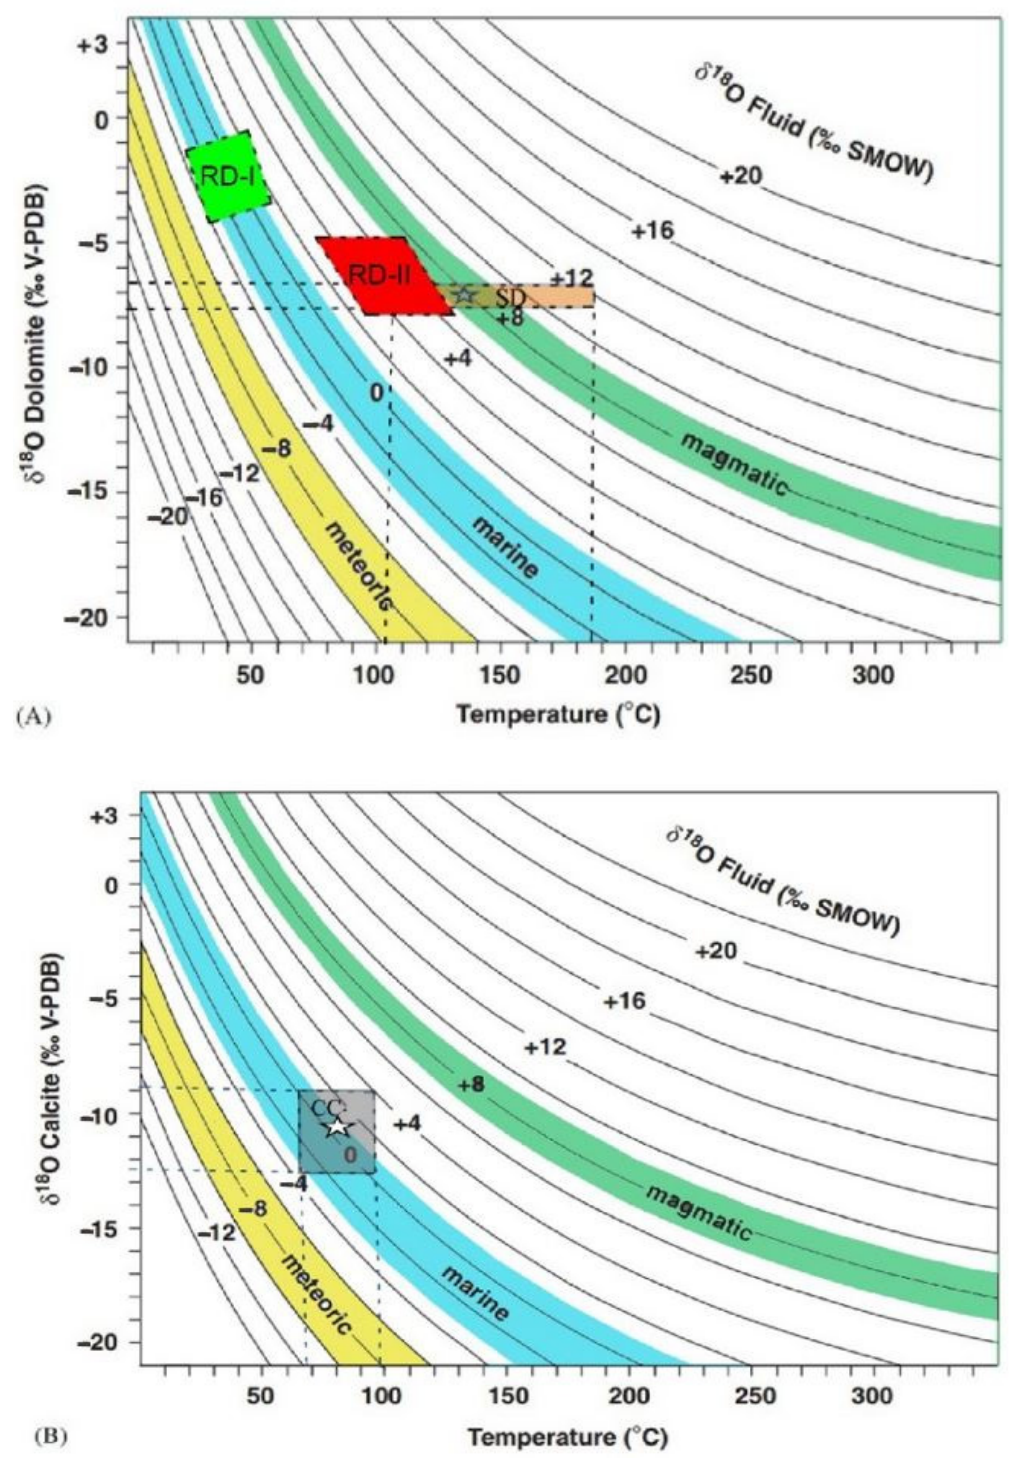
Figure 11. Homogenization temperature versus O isotopic composition of the carbonate phases analyzed: ( A ) The δ 18 O of the fluid in equilibrium with matrix dolomite (RD-I), replacive dolomite (RD-II), and saddle dolomite (SD) is calculated using the fractionation equation of land [58]. ( B ) The δ 18 O of the fluid in equilibrium with fracture-filling calcite (CC) is calculated using the fractionation equation of Friedman and O’Neil [74]. The homogenization temperature of the saddle dolomite ranges from 102.8 to 186 °C, with an average of 132.2 °C, suggesting a burial depth of 3.5 to 4 km assuming a surface